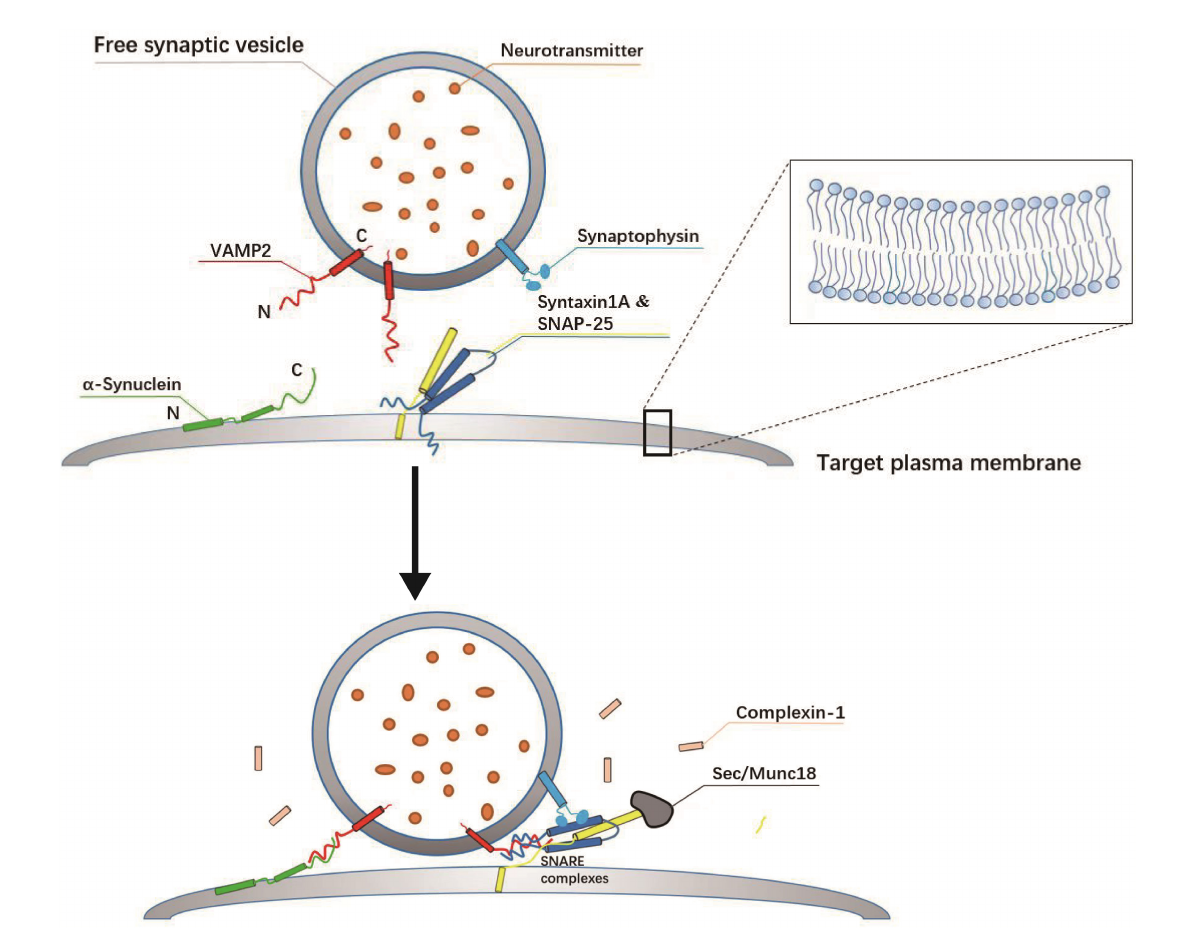
FIGURE2 Assembly mechanism of SNARE complex at the target plasma membrane. SNARE complex proteins are displayed as cylinder icons. The soluble N -ethylmaleimide sensitive factor attachment receptor (SNARE): SYX-1A (yellow), SNAP-25 (dark blue), and VAMP2 (red) form a four-helix cross SNARE complex (one from VAMP2, one from SYX-1A, and two from SNAP-25), connecting vesicles and plasma membrane, which is the key to membrane fusion. The SM protein (gray) activates the formation of the SNARE zipper, which brings the vesicle membrane and the target membrane close to each other, so the membrane fusion is thought to be the result of the synergistic action of Munc-18-1 and SNARE. In addition, synaptophysin (light blue) is thought to control the transport of VAMP2 after fusion, also located on the vesicle membrane. The complexin (pink) is a key regulator of the core fusion machinery and is required for vesicle fusion and